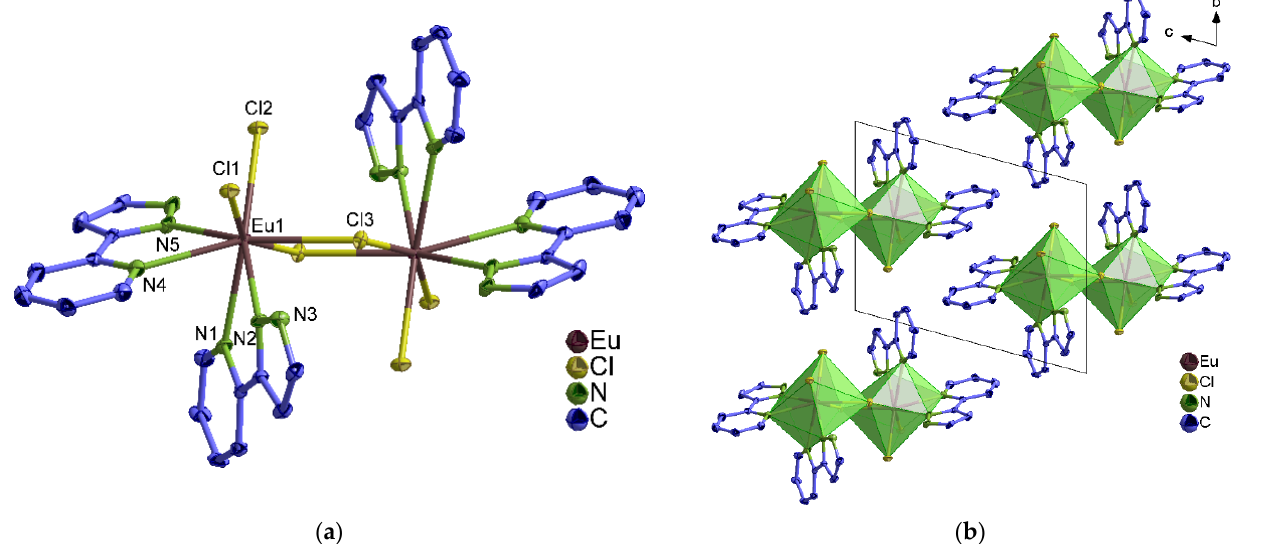
Figure 2. ( a ) Extended coordination sphere of the Eu 3+ ion in β –[Eu 2 (2–PyPzH) 4 Cl 6 ] ( 9 ) representing the isotypic compounds 8 – 10 .; ( b ) crystal structure of 9 with a view along [100].